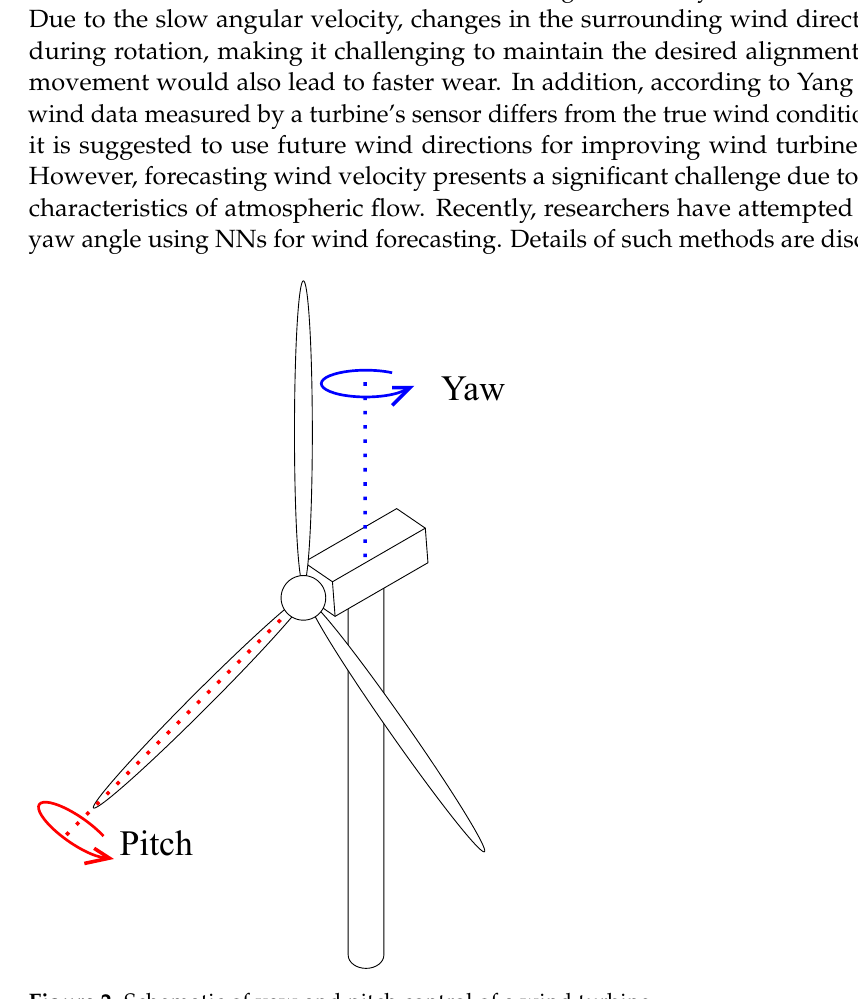
Figure 2. Schematic of yaw and pitch control of a wind